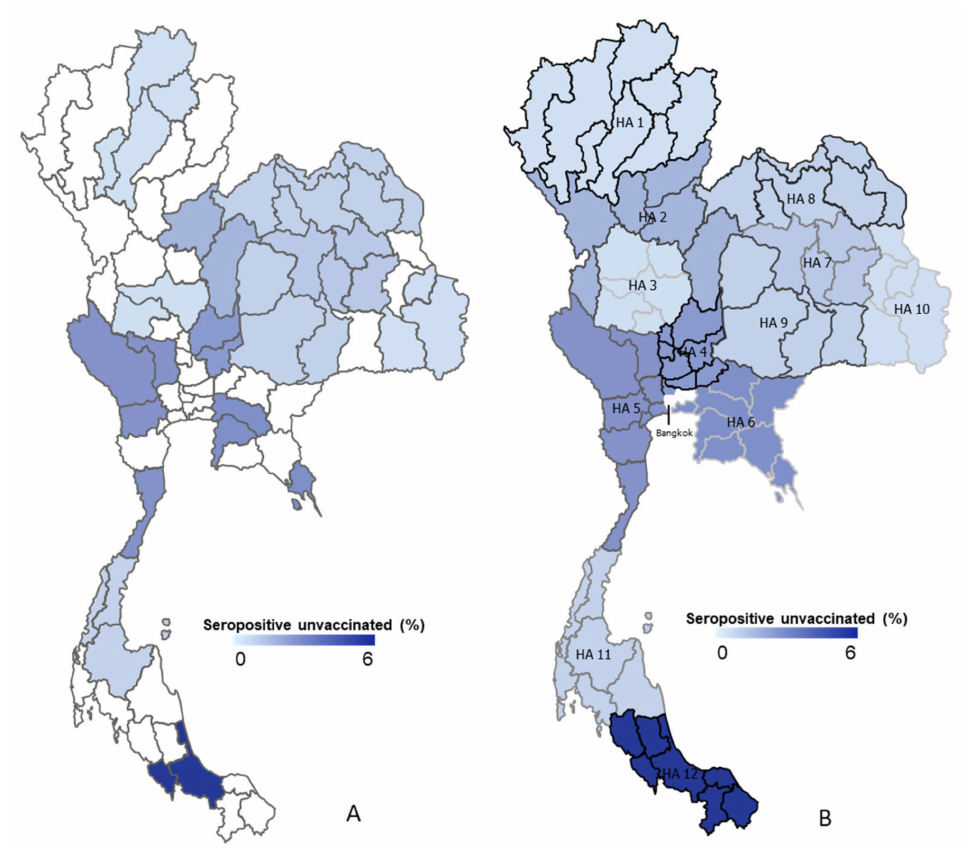
Figure 3. Mapping 13 public health areas and seropositive distributions in Thailand. ( A ) The random province sites around Thailand that show each HA (see Appendix A Table A1). ( B ) The density of seropositivity in each area of public health, which ranges from 0% to 6% seropositivity, is demonstrated by a choropleth map. HA, health